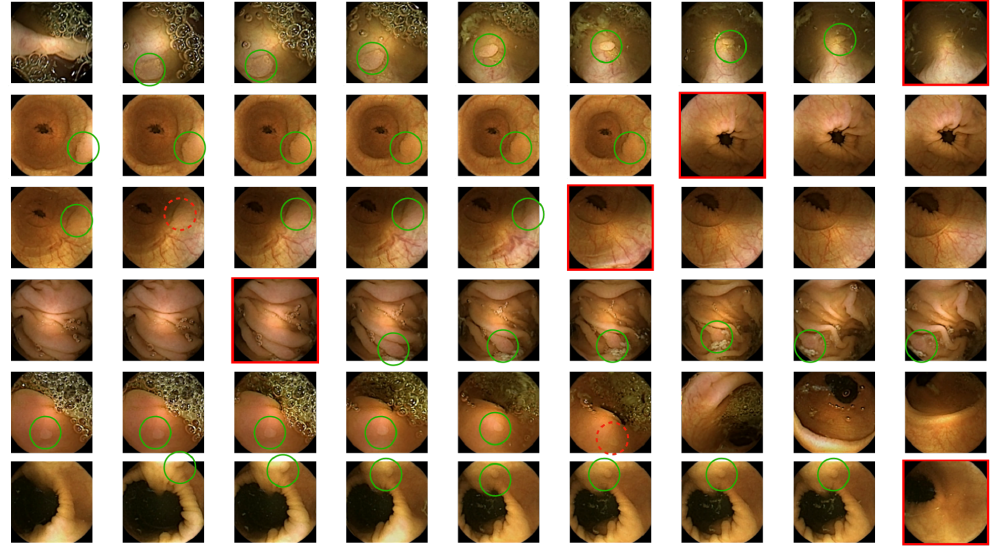
Figure 5. Image sequences. True positive detections (images correctly classified) are marked with a green circle, dashed red circle for False negatives (polyps classified as non-polyps) and images with a red border are False positives detections (non-polyps classified as